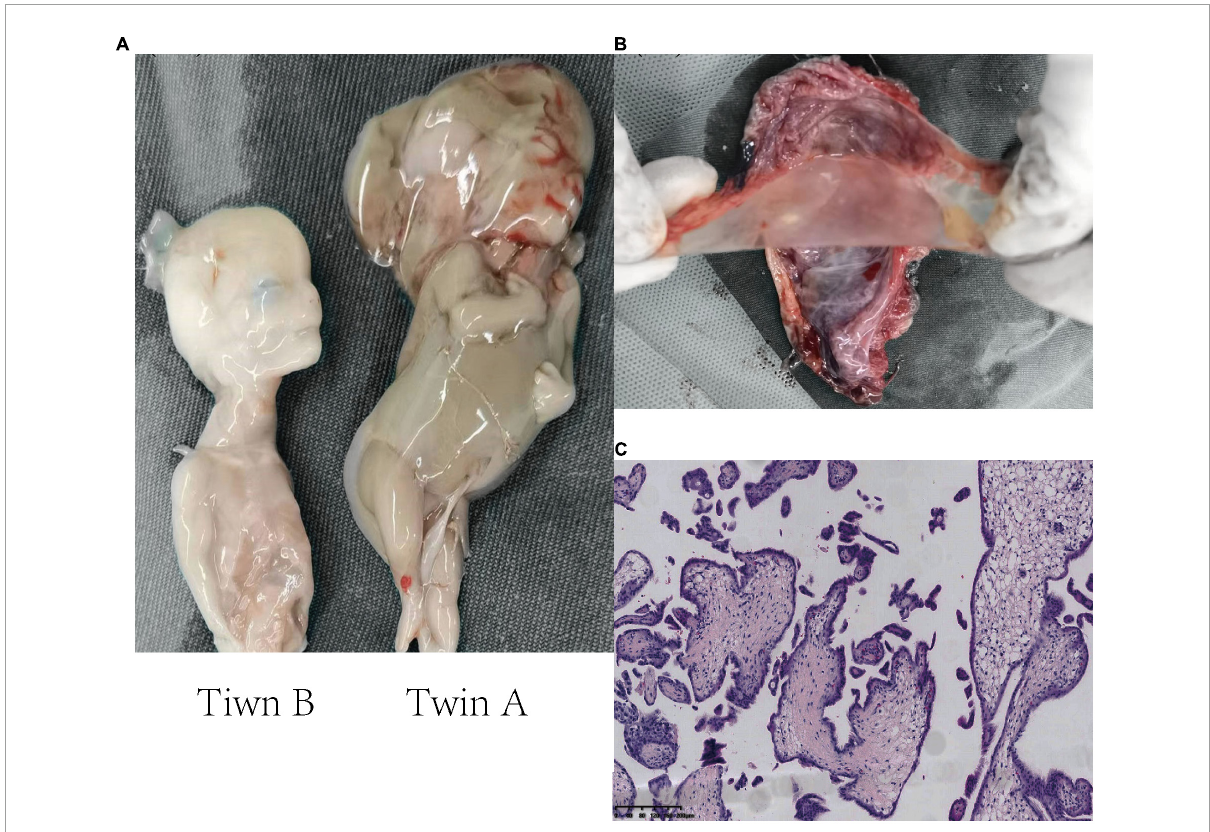
FIGURE2 Histopathology images showing the examination of two fetuses and the placenta. (A) Macroscopic examination of the twins. Twin A (right), severe cystic hygroma and generalized hydropic foetalis, appearing decaying tissue. Twin B (left), unremarkable macroscopic abnormality. (B) The monochorionic diamniotic placenta of the twins. The placental septum indicates two amniotic sacs beside thin membranes. (C) Microscopic histopathological examination of the placental section (H&E staining, 10 ×